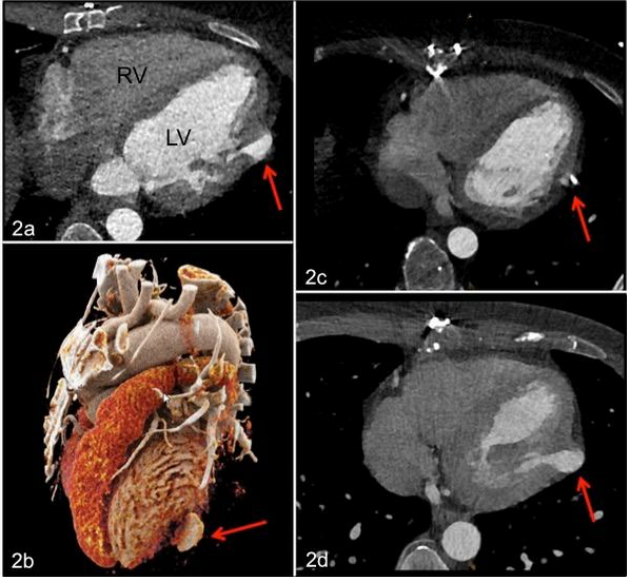
Figure 2. CT scan: 2a/b. Left ventricular pseudoaneurysm (LVP; arrow)